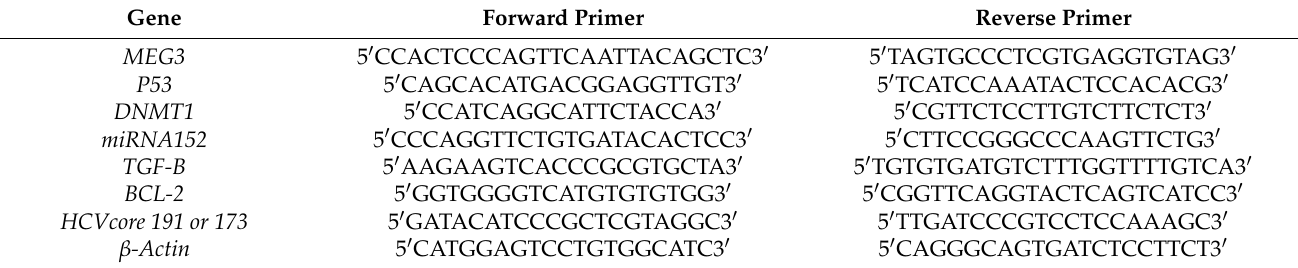
Table 1. qRT-PCR primers of genes commonly regulated by MEG3 and HCV